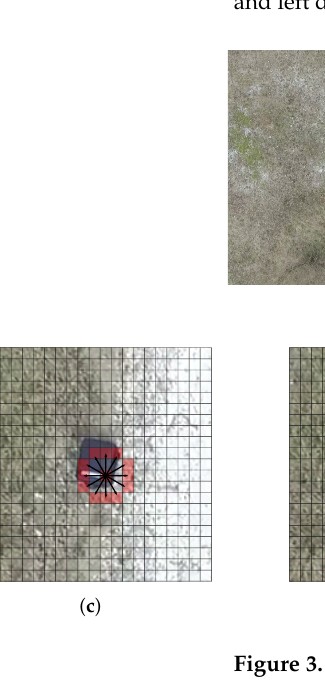
Figure 3. Proposed spatial relation of pixels used to build the GLCM. A sample frame containing an anomaly and a pixel level zoom are reported in ( a , b ). Examples of circumferences relations for r = 2,3,4,5 are shown in ( c – f ), respectively. For each pixel in the patch P , discretized circles are built using it as a center. ( a ) Input image showing an anomaly, highlighted by the red bounding box. ( b ) Anomaly at the pixel level. ( c ) Circumference with r = 2. ( d ) Circumference with r = 3. ( e ) Circumference with r = 4. ( f ) Circumference with r =